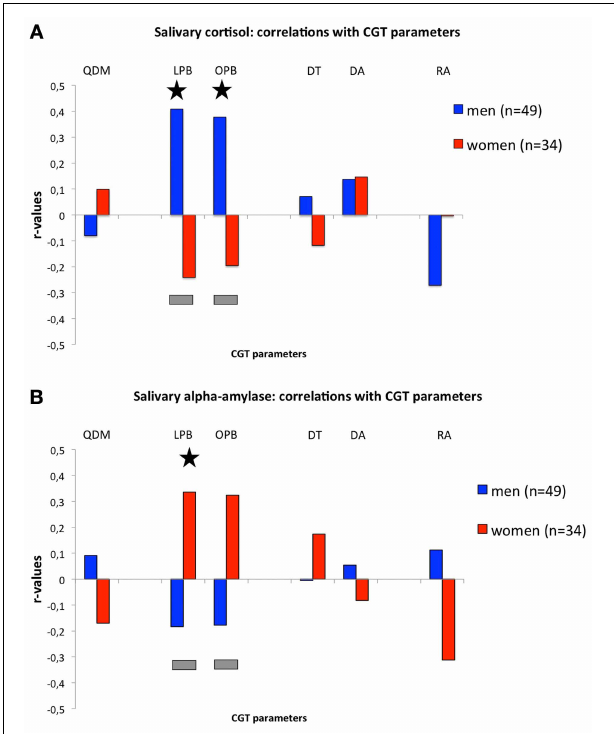
FIGURE 1 | (A) Correlations ( r -values; y-axis) between cortisol levels during the CGT and CGT parameters (x-axis). (B) Correlations ( r -values; y-axis) between alpha-amylase levels during the CGT and CGT parameters (x-axis). For both panels: QDM, quality of decision-making; LPB, likely proportion bet; OPB, overall proportion bet; DT, deliberation time; DA, delay aversion; RA, risk-adjustment. Gray bars indicate significant differences between r -values of men and women (see text for details); asterisks indicate significant r -values (see text for